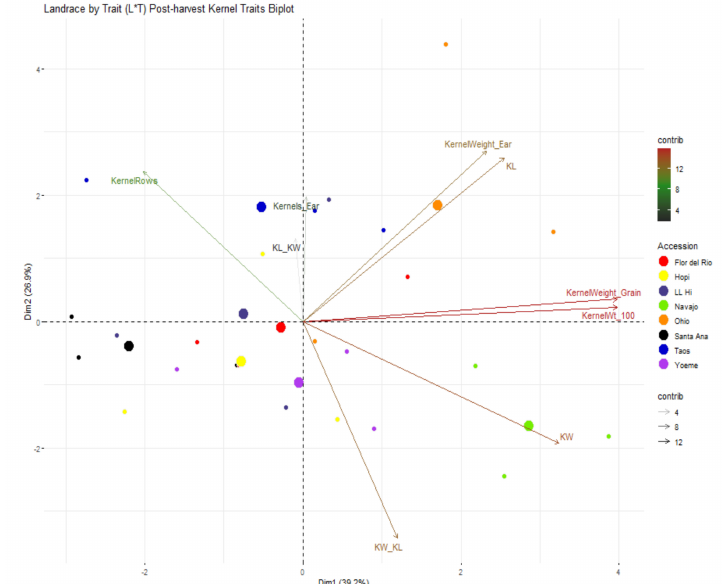
Figure 9. Landrace by trait (L*T) biplot for post-harvest kernel traits. Some traits shown in this figure has been abbreviated and full forms for the abbreviated traits are presented in Table 5. Landraces from Navajo Blue, LL High, Santa Ana Blue, Flor del Rio, Yoeme Blue, Ohio Blue, Hopi Blue, and Taos Blue are shown in “chartreuse2”, “slateblue4”, “black”, “red1”, “darkorchid2”, “darkorange”, “yellow” and “blue3”, respectively. Traits contributing to PC1 and PC2 are also assigned different colors with a gradient ranging from 4, 8, and 12 with “gray15”, ”forestgreen” and “firebrick” respectively. Larger consensus points for each accession discerns the midpoint of a given